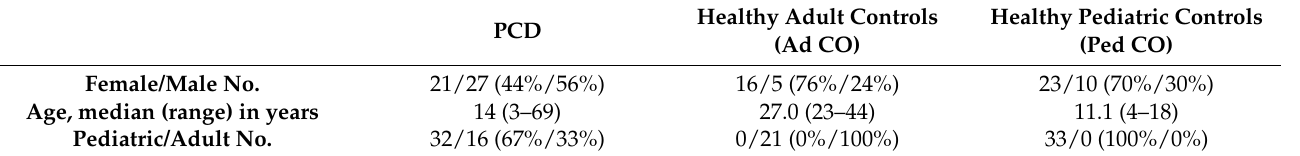
Table 1. Patient